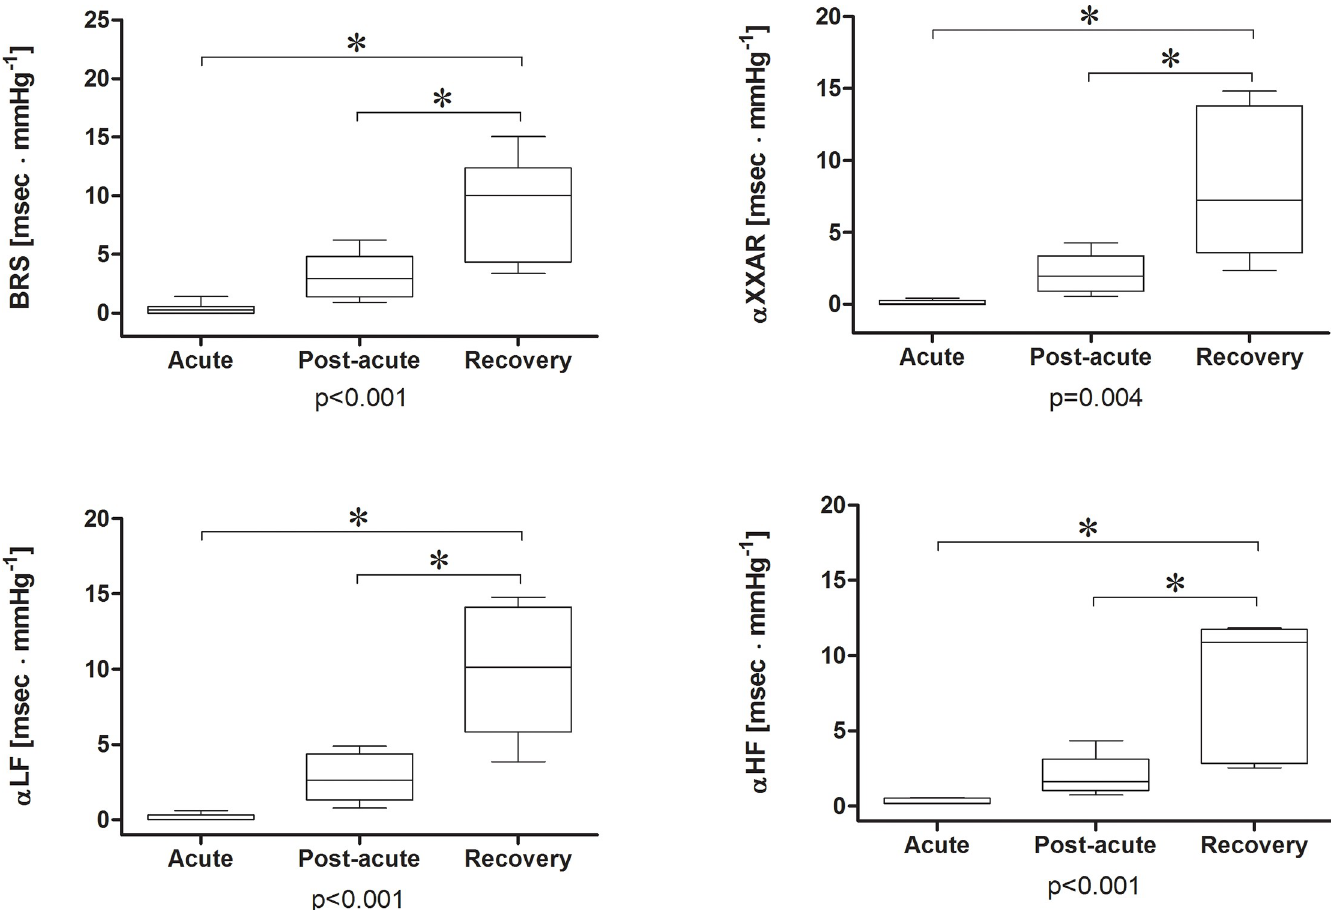
Fig 2. Baroreflex control of patients who experienced shock during idiopathic systemic capillary leak syndrome flares. The baroreflex control was severely depressed during the shock phase and gradually reappeared during the post-acute and recovery phases. � p < 0.05 for post-hoc analysis of ANOVA on ranks.